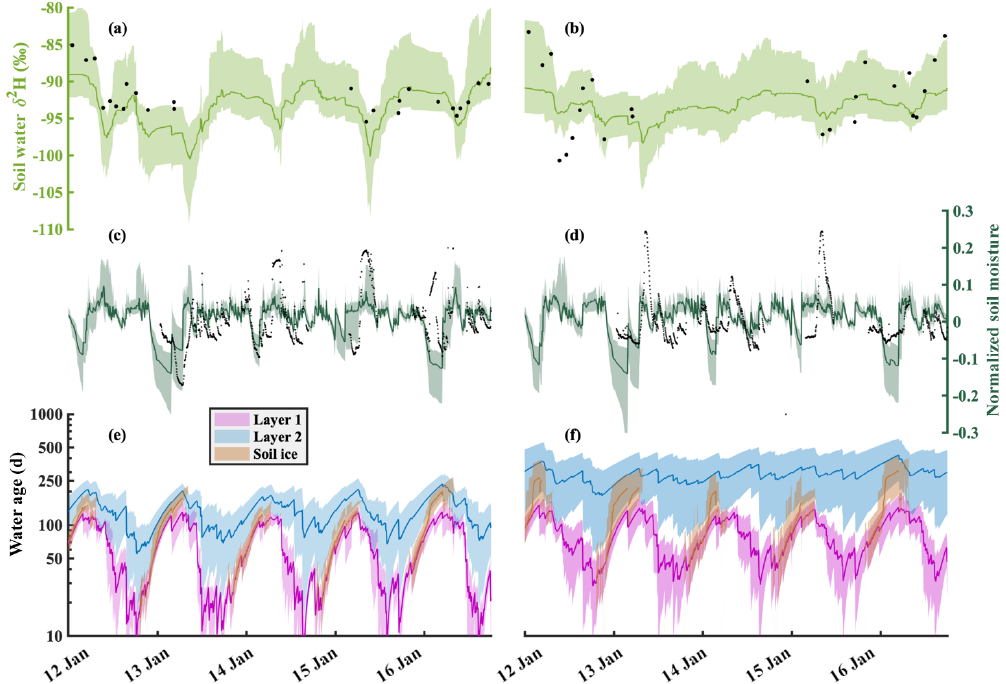
Figure 3. Simulation 90% bounds and mean simulation (solid line) for the average of layers 1 and 2 δ 2 H for (a) site S12 and (b) site S22; the average of layers 1 and 2 soil moisture standardized by the mean for (c) site S12 and (d) site S22; and water ages of soil layers 1 and 2 and soil frost for (e) site S12 and (f) site